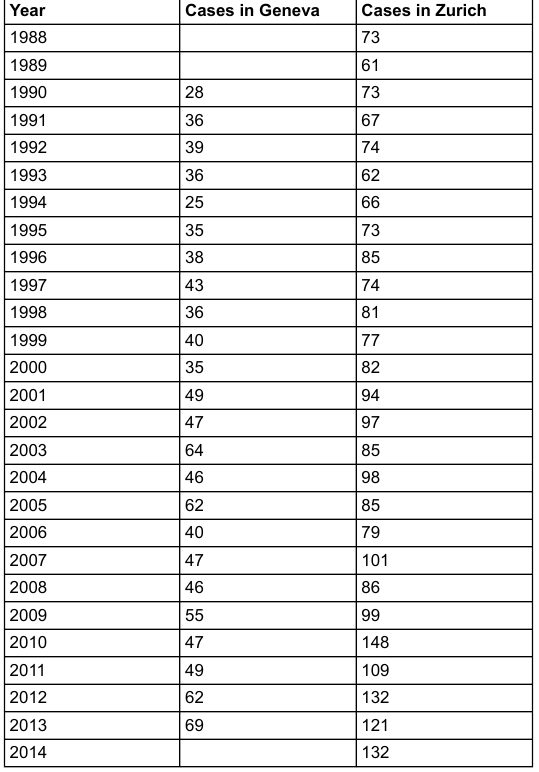
Table 2: Annual number of reported liver cancer